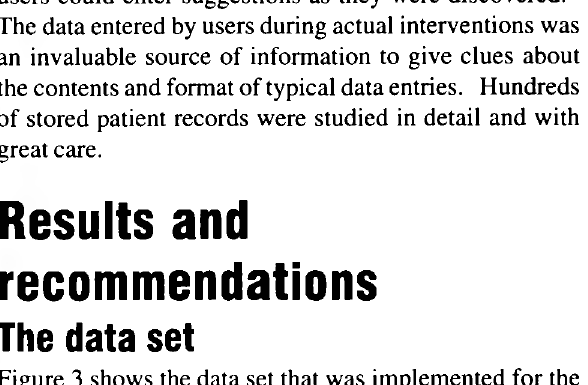
Figure 2 : On-line suggestion box SUGGESTION BOX